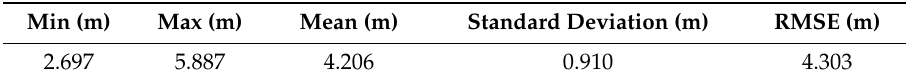
Table 14. Statistical values of the residuals for the North coordinates resulting from datum transformation UTM / ED50 to UTM / WGS84 based on automatic QGIS application. Table 13. Statistical values of the residuals for the East coordinates resulting from datum transformation UTM/ED50 to UTM/WGS84 based on automatic QGIS application.